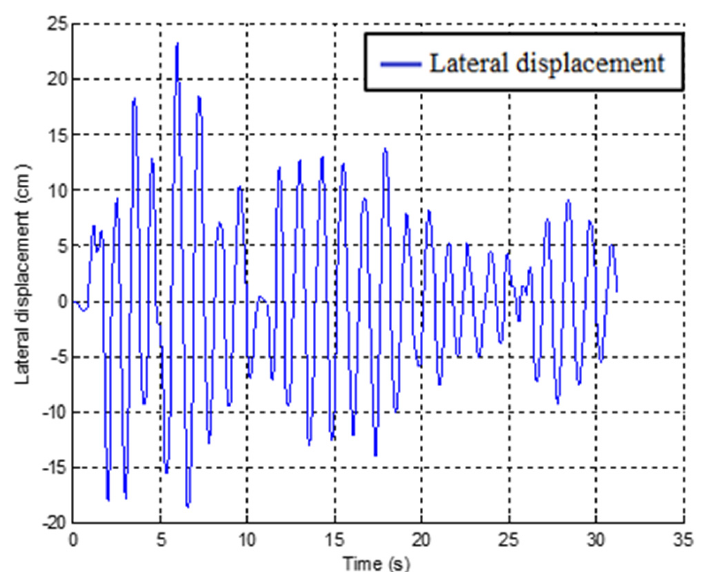
Figure 2. Top lateral displacement time histories of both non-isolated buildings.